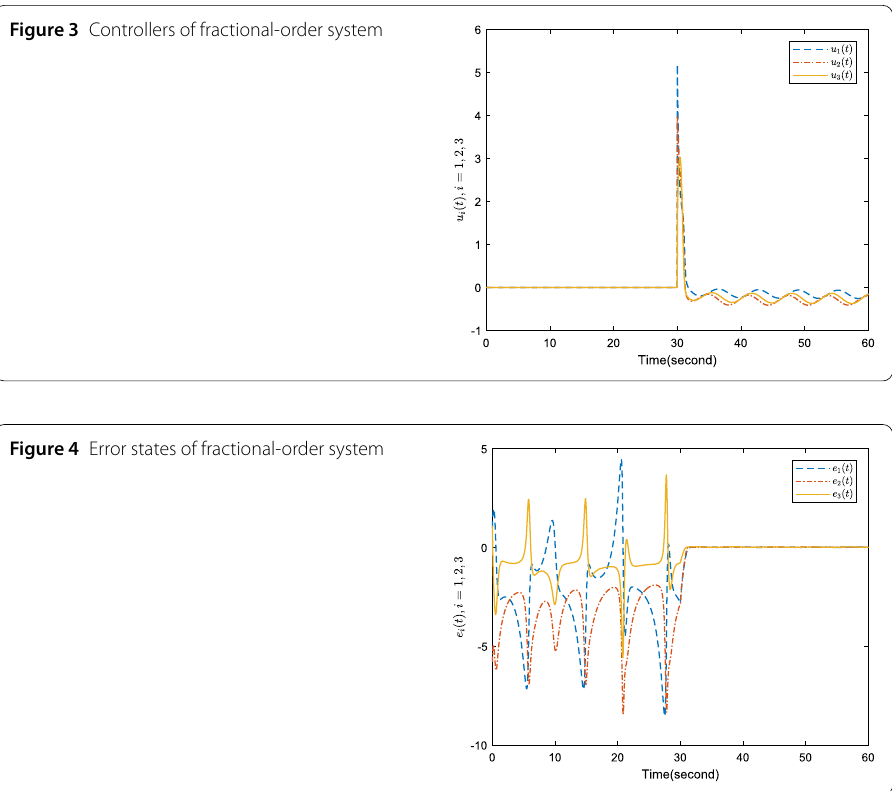
Figure 3 Controllers of fractional-order system